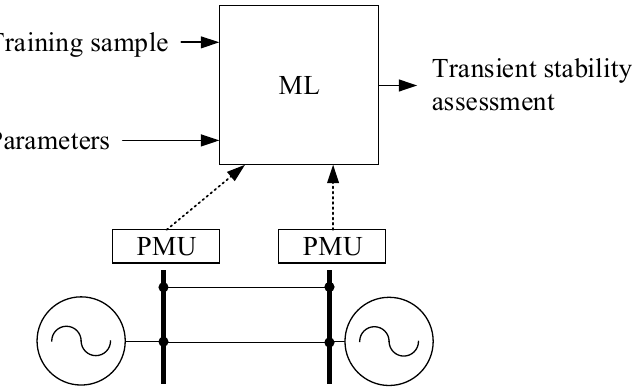
Figure 8. Possible ML model integration for transient stability analysis.